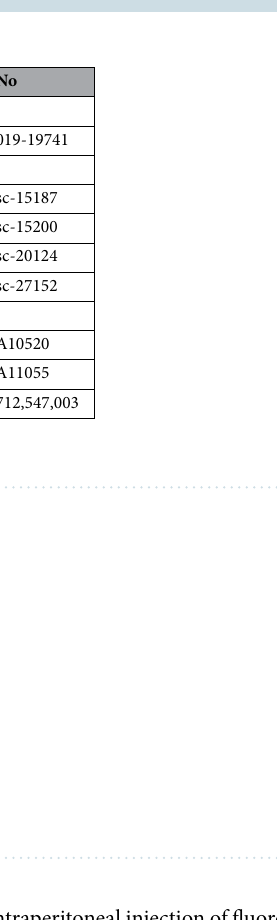
Table 2. Negative controls were obtained by staining procedures that omitted the primary antibody. A fluores- cence microscope (EVOS fl, Advanced Microscopy Group, USA) was used to acquire images. Reverse transcription and real-time quantitative PCR.